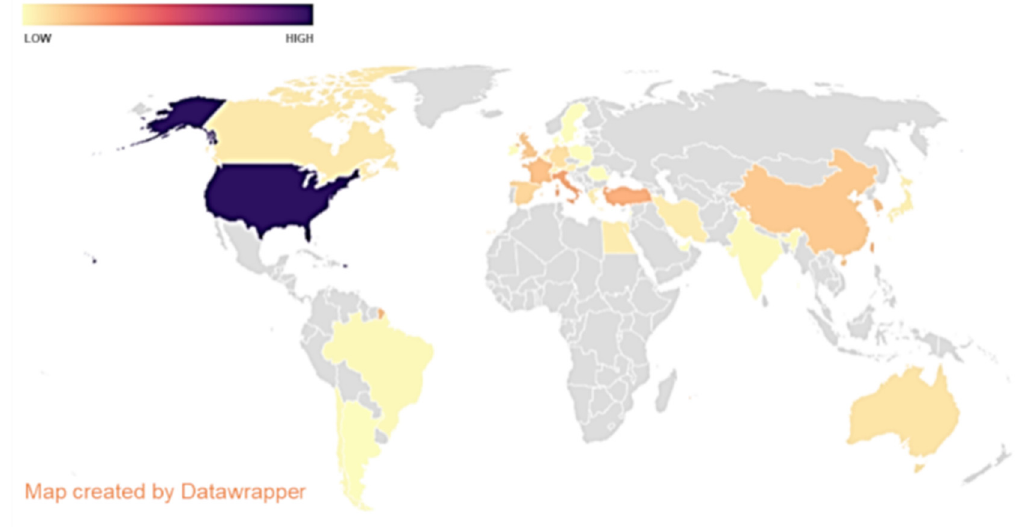
Figure 2. Literature production of the countries. Gray represents the countries with no associated papers.